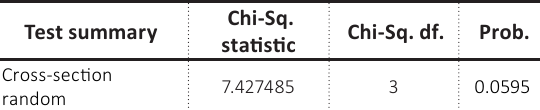
Table 3. Hausman test